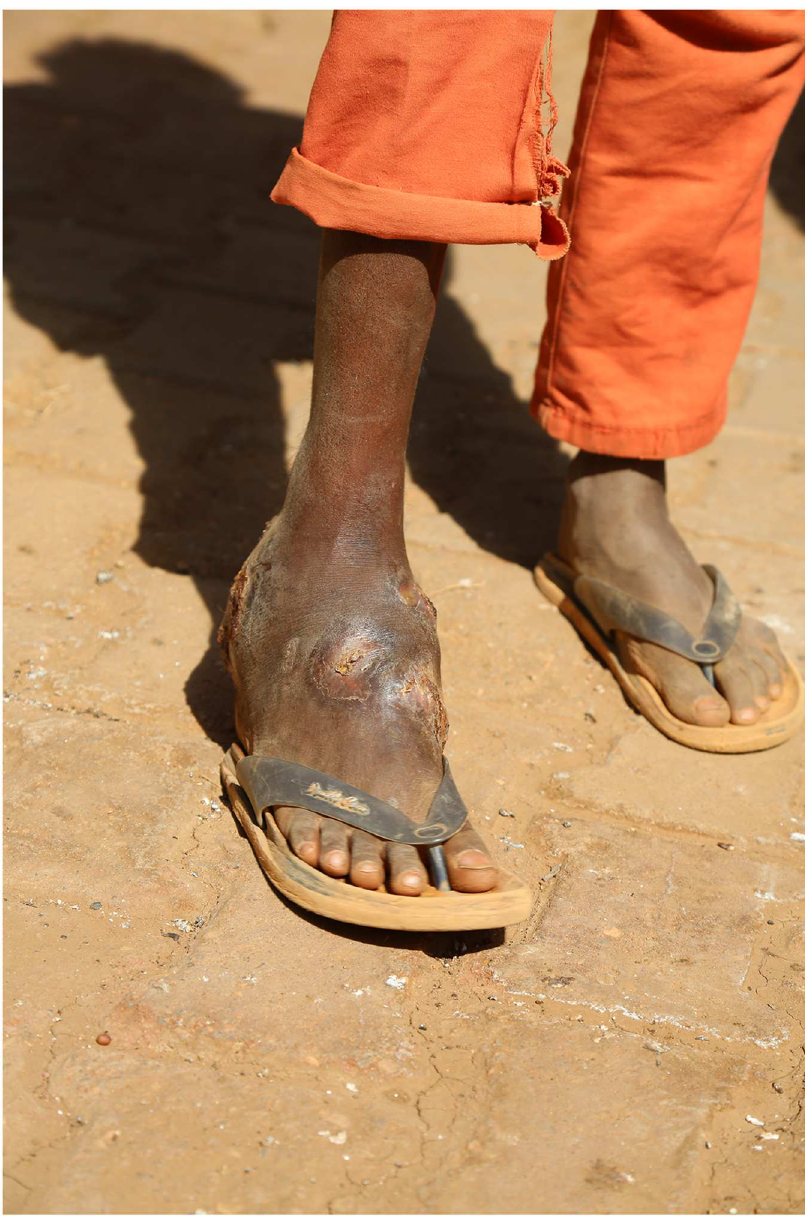
Fig 1. Photography showing massiveneglected foot